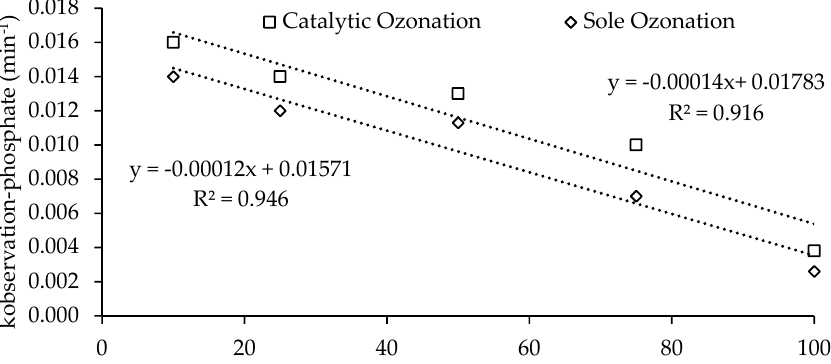
Figure 11. Effect of phosphate on the performance of catalytic ozonation.